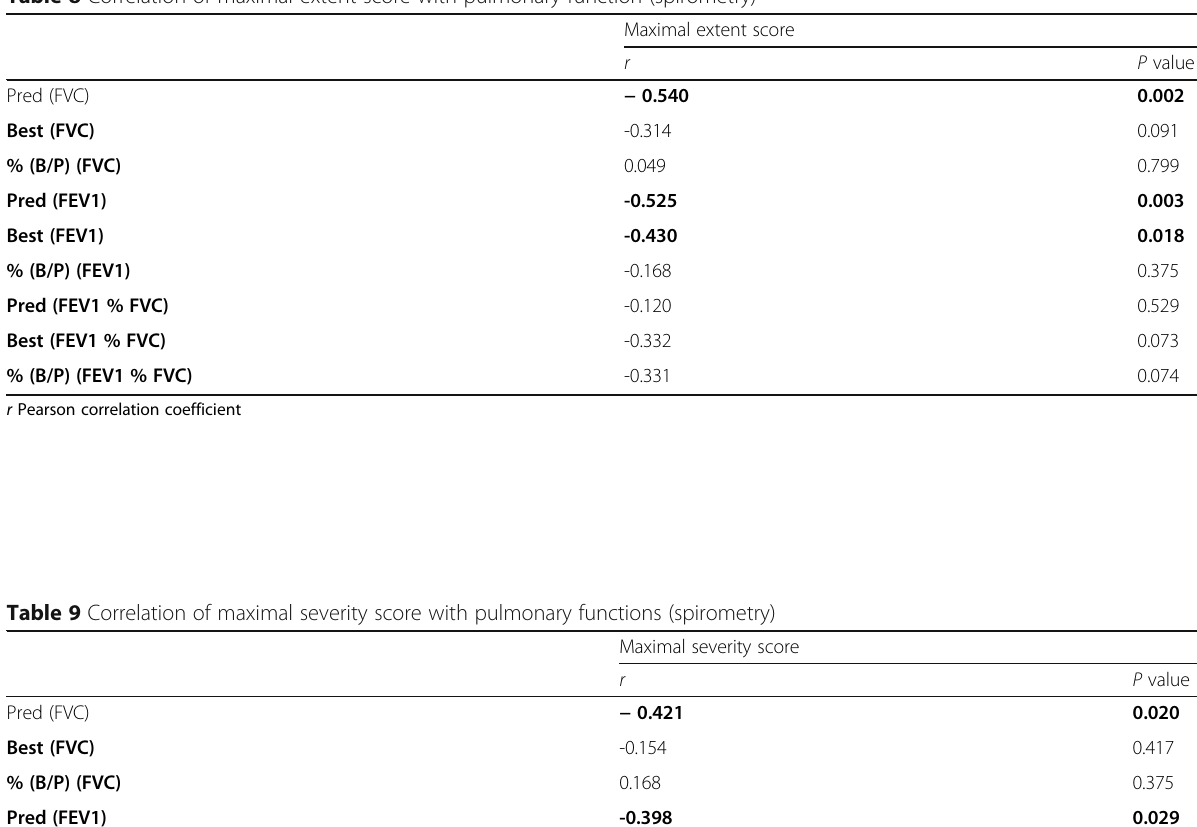
Table 8 Correlation of maximal extent score with pulmonary function (spirometry)